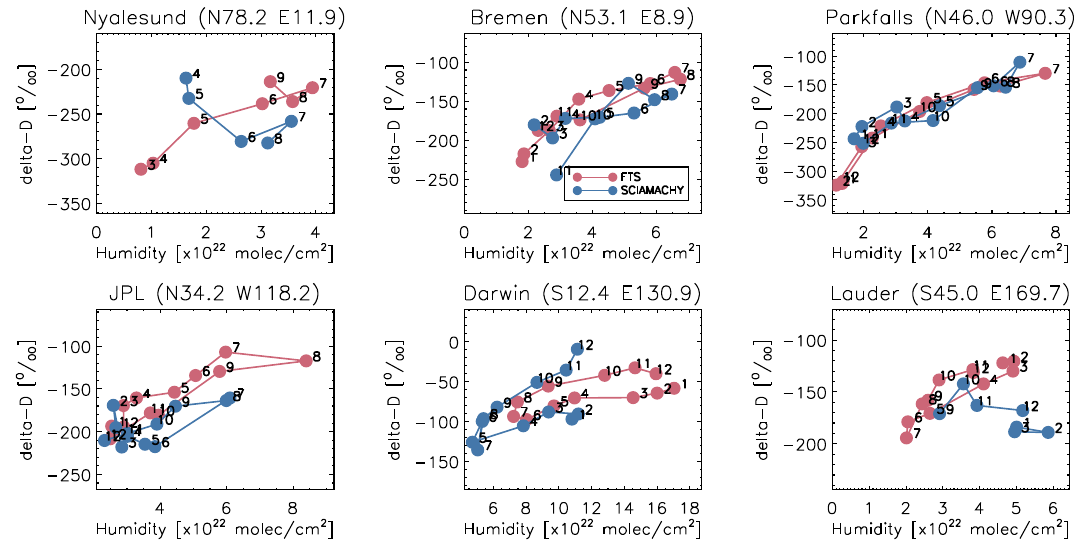
Figure 12. Monthly means of δD as a function of humidity for the six TCCON stations (magenta) compared to spatially co-located SCIA- MACHY measurements (blue, corrected for the offset). Subsequent months (numbered) are connected by lines.